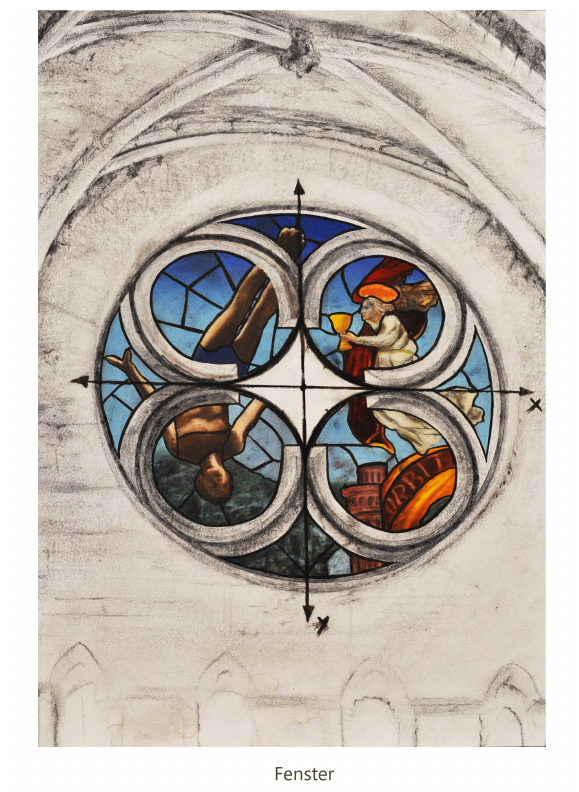
Figure 1. Unit l p -circle with p = 1/2 ( Fenster , Oil and pencil on paper, 42 × 30).